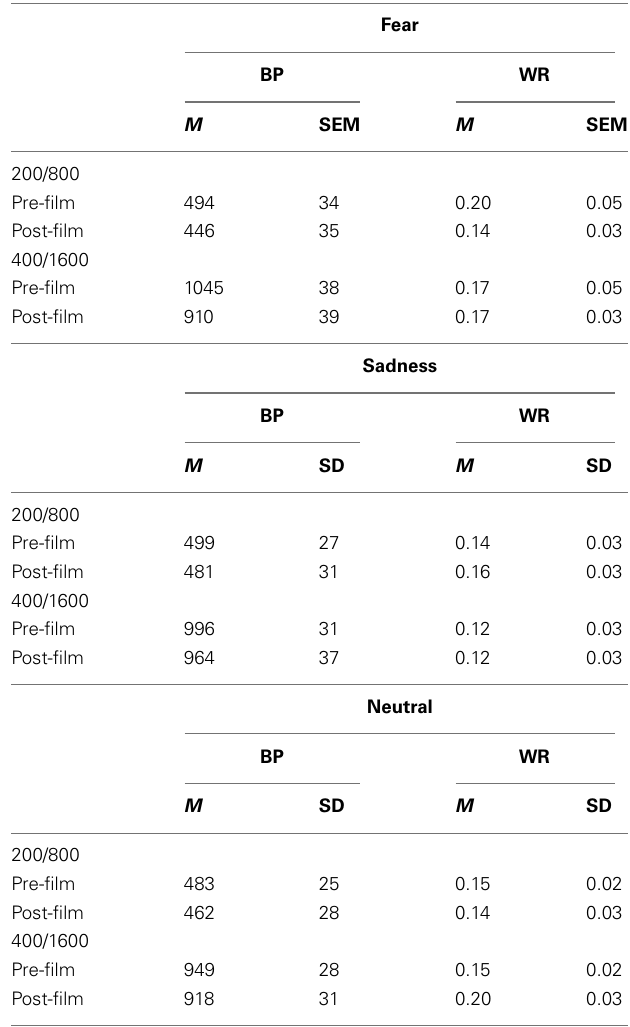
Table 2 | Mean ( M ) and SEM for bisection point (BP) andWeber ratio (WR) for the films inducing fear and sadness as well as for the neutral films before and after viewing the